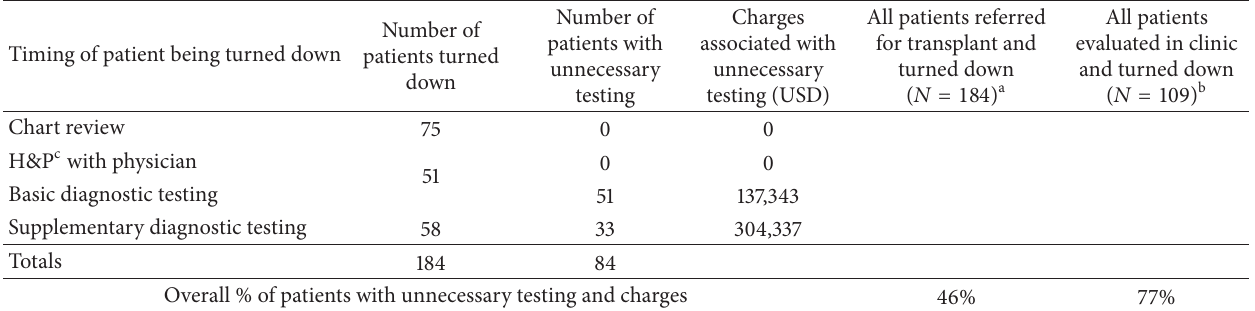
Table 4: Summary of all patients turned down for transplant and unnecessary